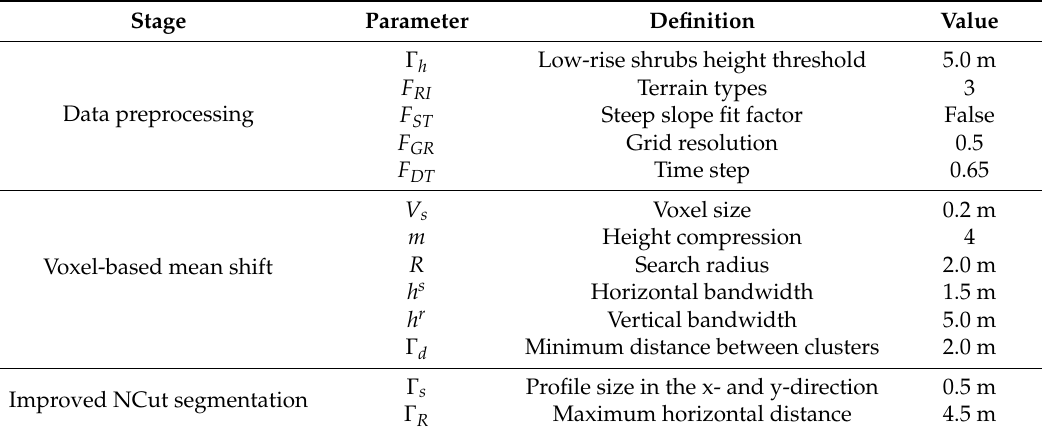
Table 4. Parameters and configurations in the proposed